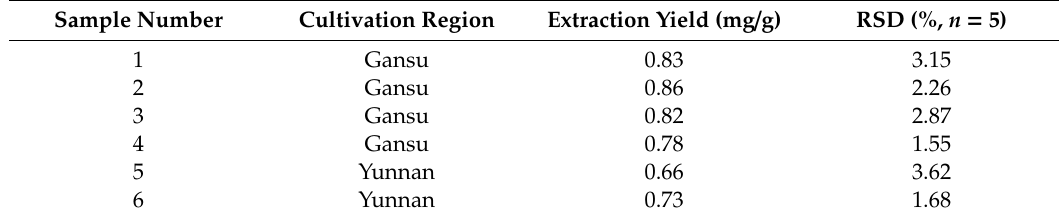
Table 3. Analysis of Real